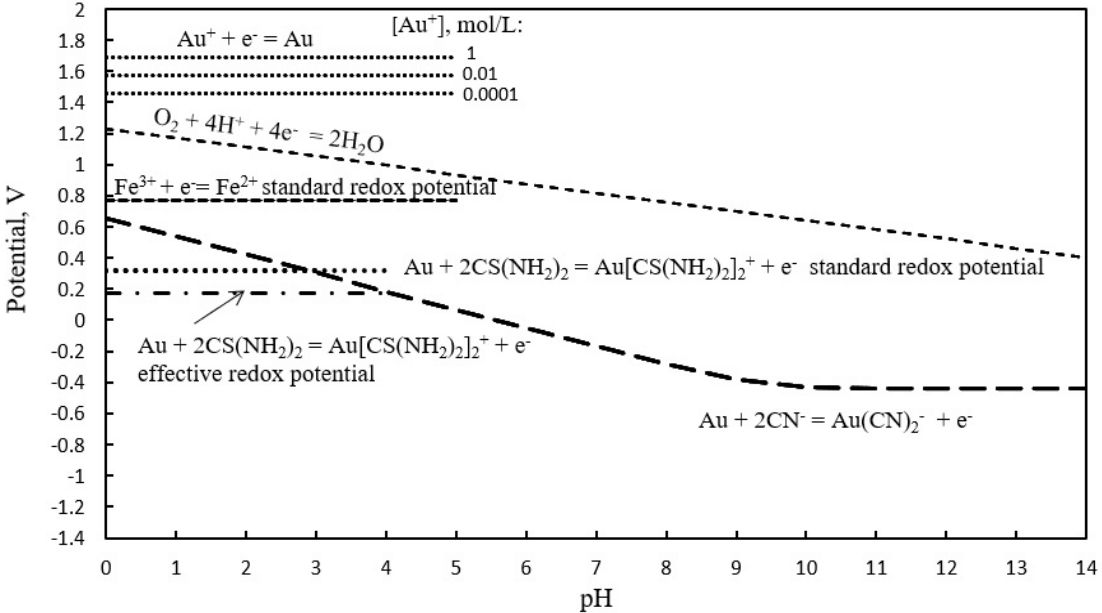
Figure 1. Potential-pH equilibrium diagram illustrating features of the Au-thiourea-H 2 O and Au-cyanide-H 2 O systems at 25 °C. [CN − ] total = 1 × 10 −4 mol/L, Au(CN) 2− = 1 × 10 −3 mol/L, Au + = 5 × 10 −4 mol/L, CS(NH 2 ) 2 = 0.33 mol/L, Fe 3+ = 0.11 mol/L.